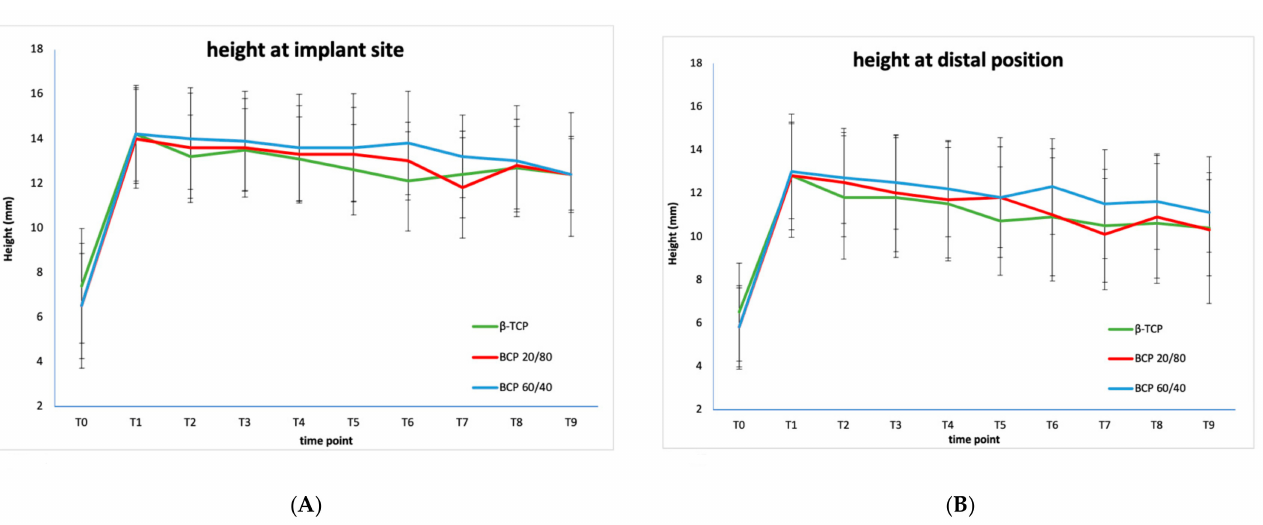
Figure 2. Mean tissue height changes at implant site ( A ) and distal position ( B ) measured (in mm) over a period of 5 years. T0 ( − 8): patient intake, T1 ( − 6): maxillary sinus floor elevation, T2 ( − 1): ridge mapping, T3 (0): dental implant placement, T4 (3): prosthetic loading, T5 (12): follow-up visit after 1 year, T6 (24): follow-up visit after 2 years, T7 (36): follow-up visit after 3 years, T8 (48): follow-up visit after 4 years, T9 (60): follow-up visit after 5 years. β -TCP: β -tricalcium phosphate; BCP: biphasic calcium phosphate; HA: